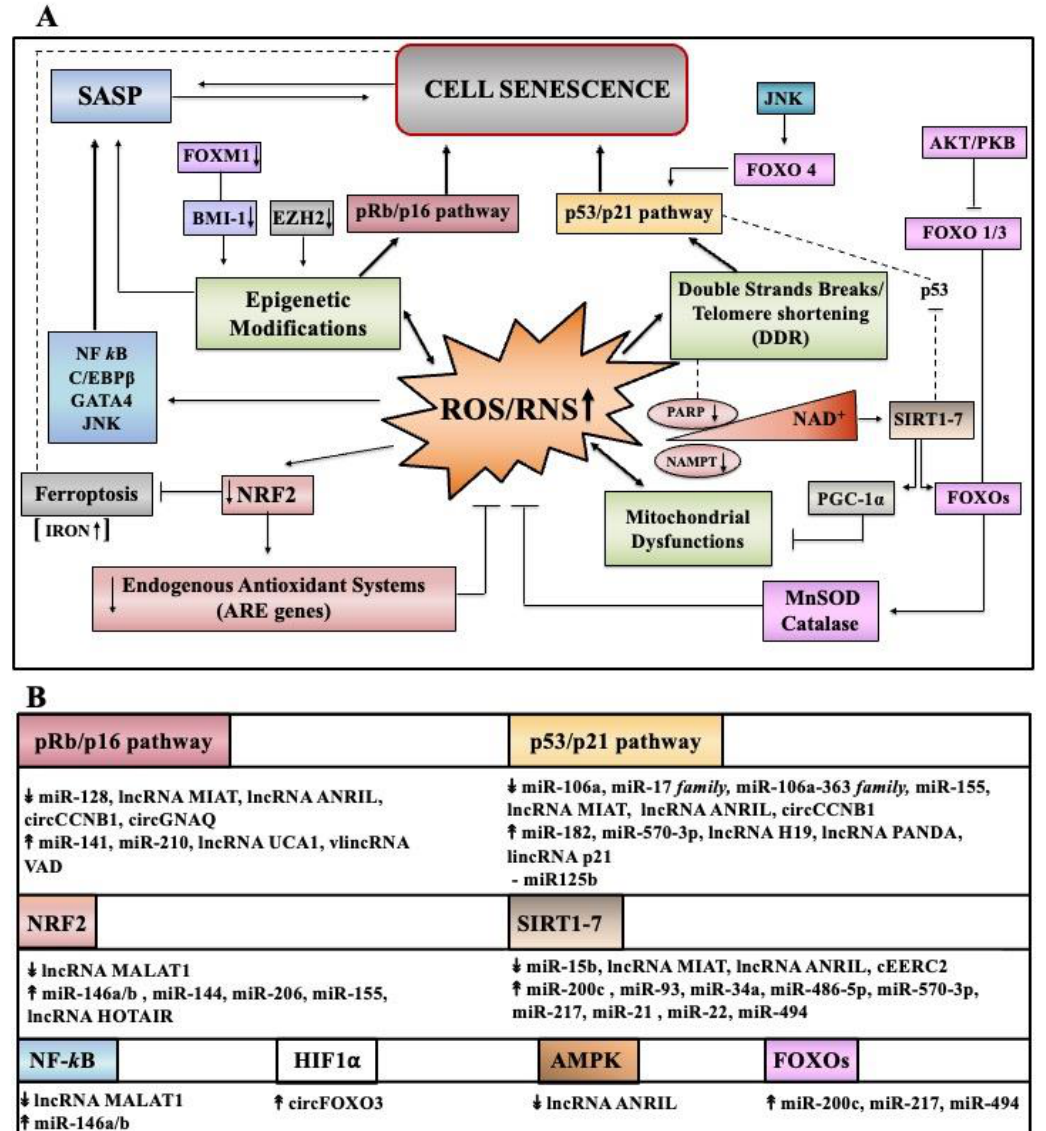
Figure 3. Summary of major pathways initiating senescence through ROS/RNS deregulation. ( A )